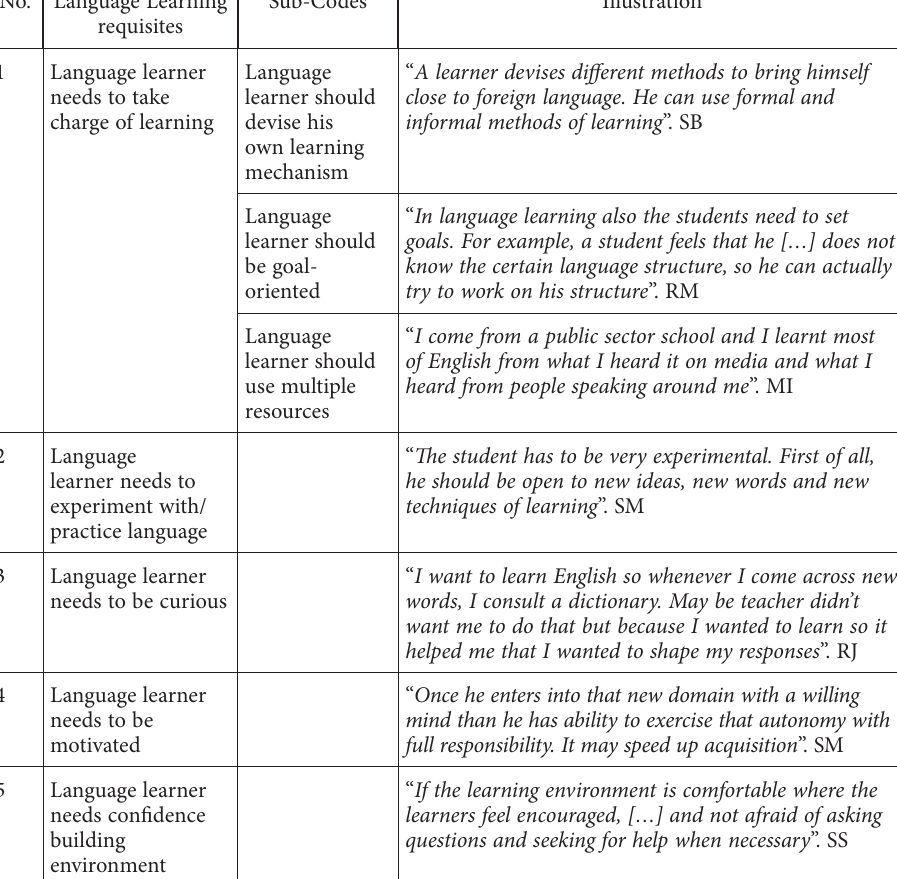
Table 1. Transforming teaching practices to foster learner autonomy (Source: created by